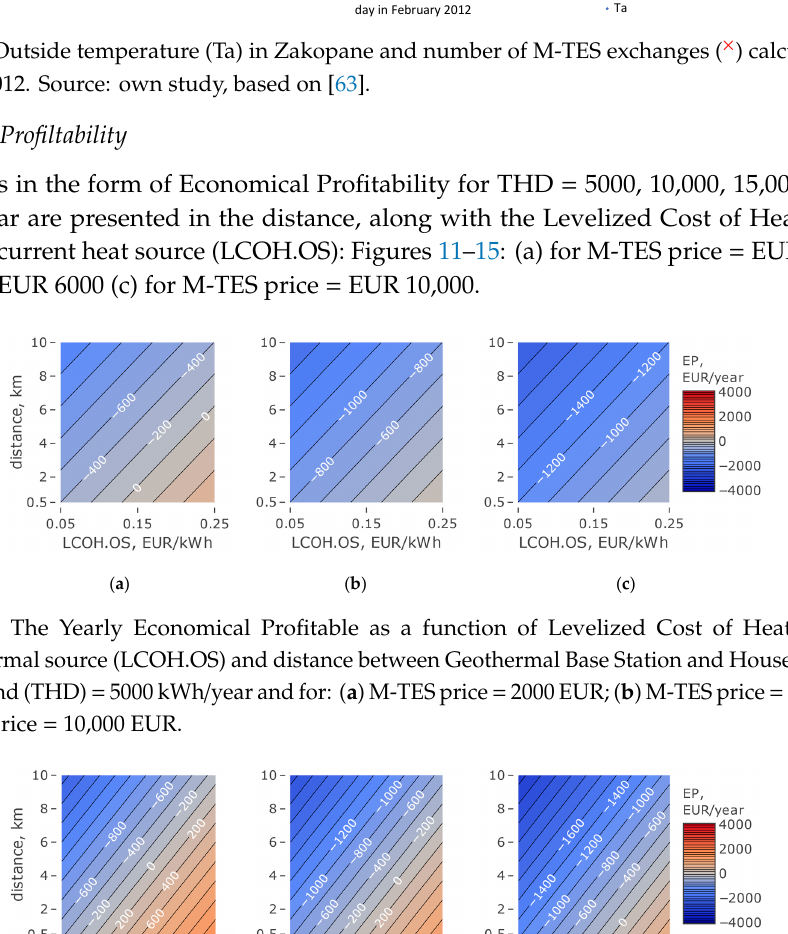
Figure 12. The Yearly Economical Profitable as a function of Levelized Cost of Heating from non-geothermal source (LCOH.OS) and distance between Geothermal Base Station and House, for Total Heat Demand (THD) = 10,000 kWh/year and for: ( a ) M-TES price = 2000 EUR; ( b ) M-TES price = 6000 EUR; ( c ) M-TES price = 10,000 EUR.